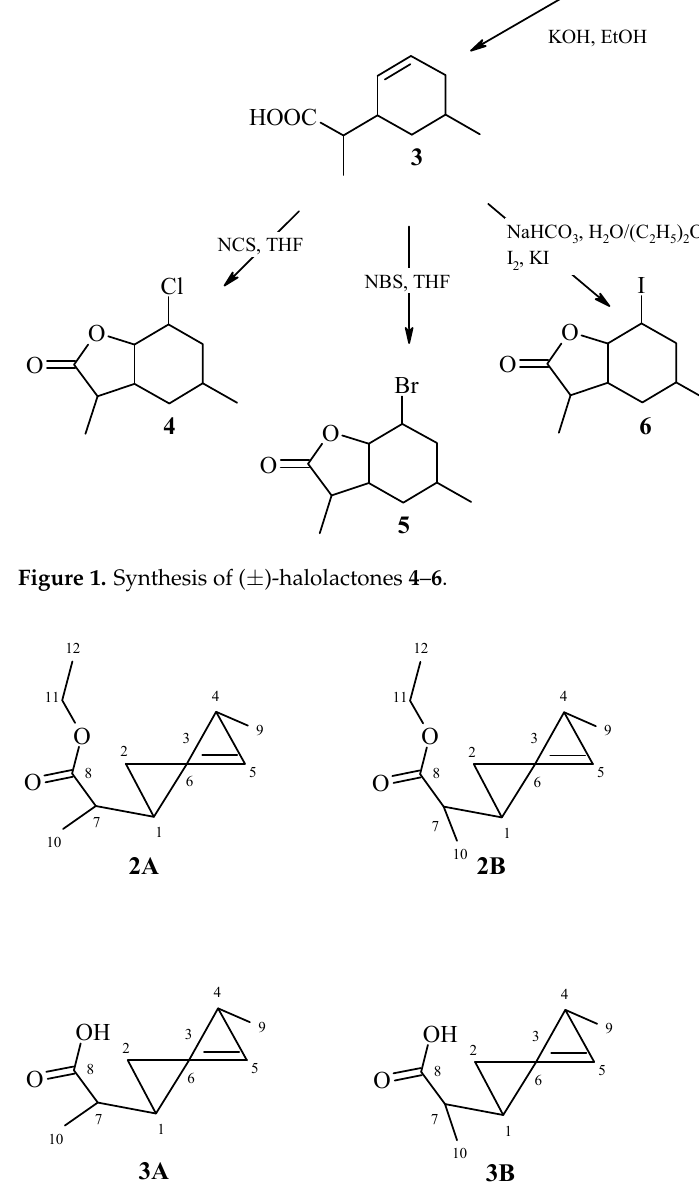
Figure 2. The structures of ester 2 and acid 3 . The comparison of the chemical shifts of the signals coming from the H-7A and H-7B protons allowed to determine the arrangement of the CH 3 -10 methyl group in the